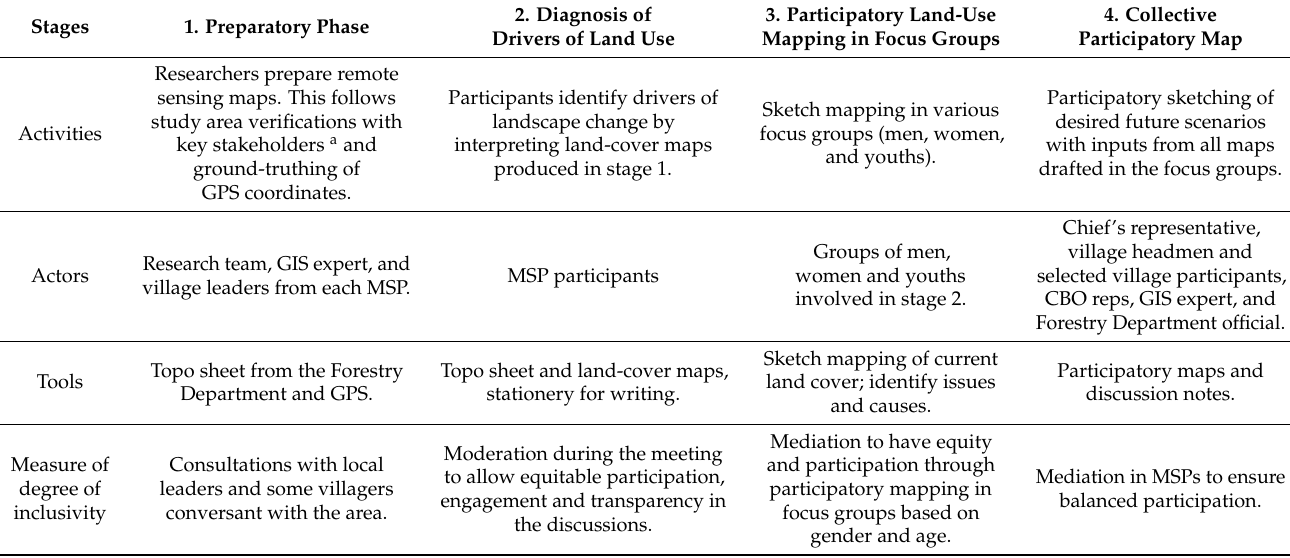
Table 3. Participatory mapping process in the two